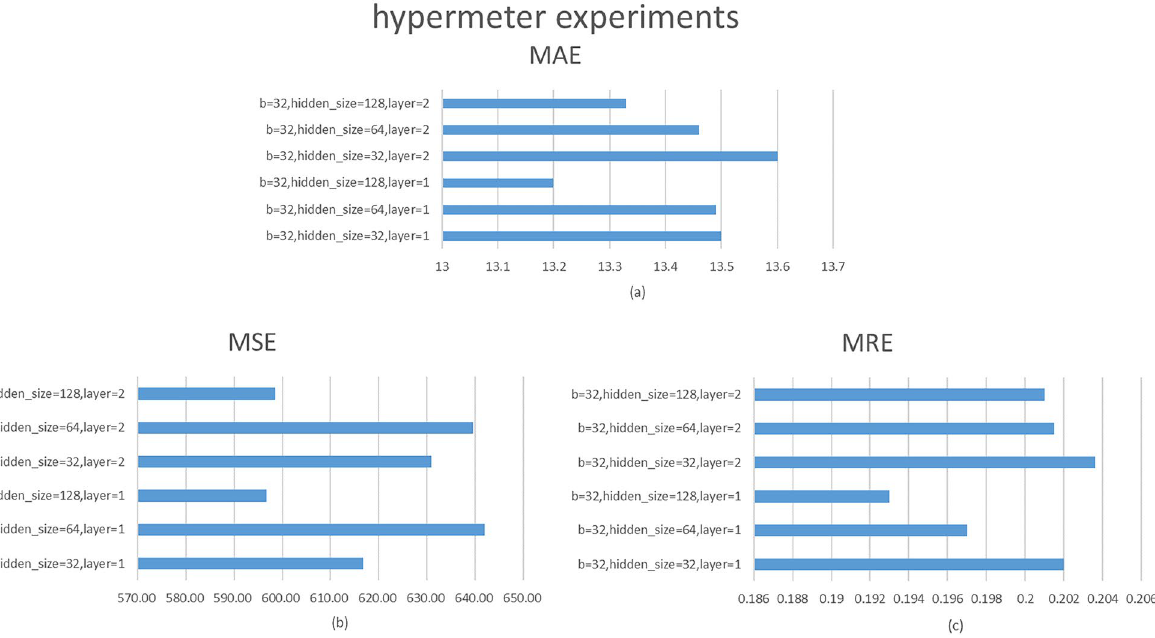
Figure 6. Hyperparameter experimental